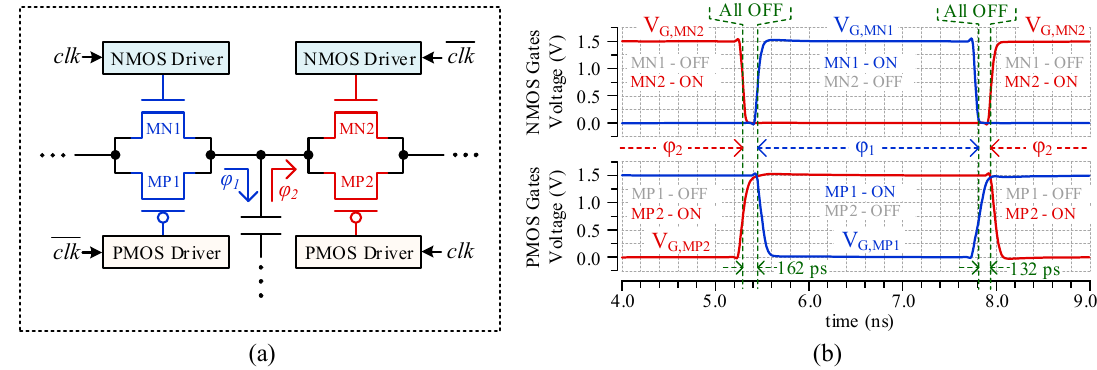
Figure 8. ( a ) Transmission gate switches controlled by Non-Overlapping Signal Drivers (NOSDs). For example, the blue transmission gate indicates cA 0 and the red transmission gate indicates cB 0 of Figure 7. ( b ) Post-layout simulation of the NOSDs, demonstrating non-overlapping control to mitigate short- circuit losses.